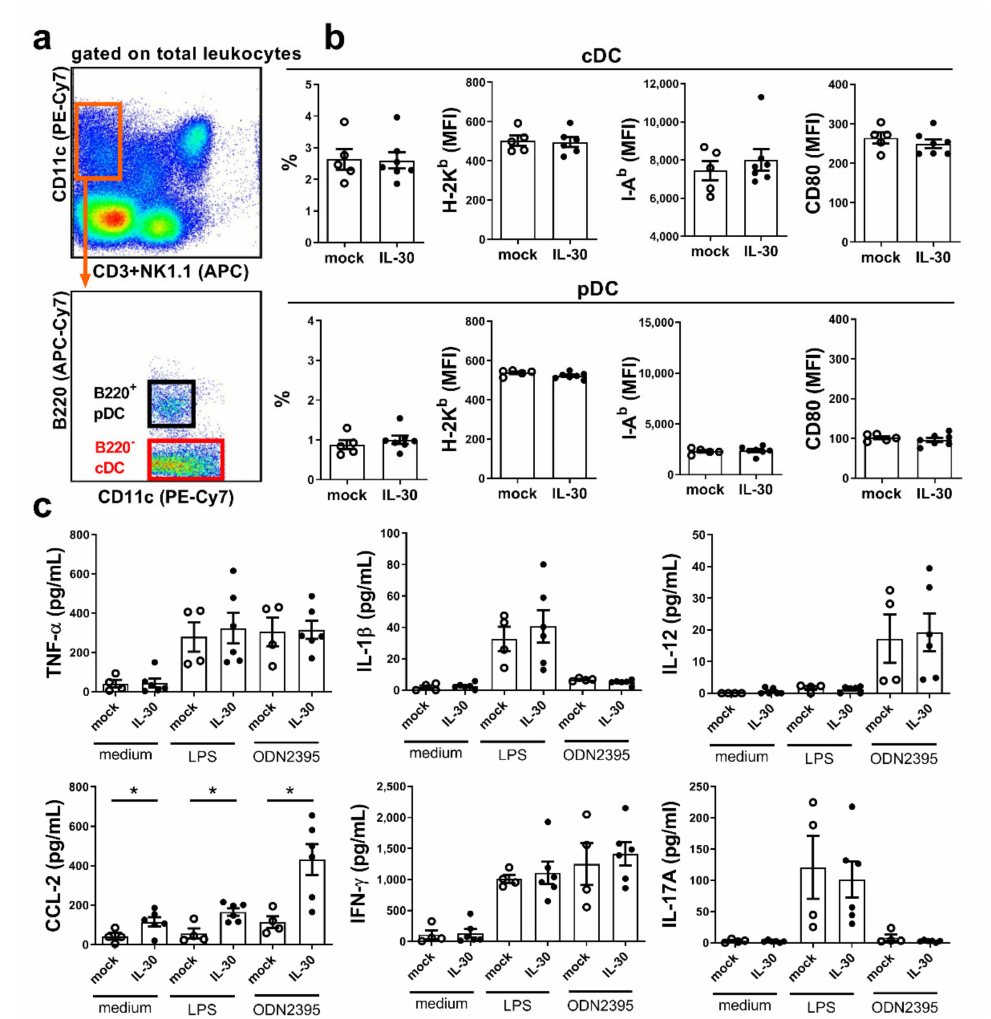
Figure 4. IL-30 did not affect antigen-presenting cells in 2-OA-OVA-induced autoimmune cholangitis mice. Mice were injected with AAV-mIL-30 or AAV-mock at 3 weeks after the first 2-OA-OVA immu- nization and sacrificed at Week 5. ( a ) Representative flow plots show gating strategies of conventional dendritic cells (cDCs) and plasmacytoid dendritic cells (pDCs). ( b ) The percentage and H-2K b , I-A b , and CD80 expression of cDCs and pDCs were detected using flow cytometry. cDCs were identified as CD3 − NK1.1 − CD11c + B220 − cells, whereas pDCs were identified as CD3 − NK1.1 − CD11c + B220 + cells. ( c ) Liver leukocytes were isolated, stimulated with LPS or ODN2395, and their cytokine/chemokine production was detected by performing a fluorescent bead-based multiplex immunoassay. Each dot represents an individual mouse. n = 4–6 mice per group. All error bars denote ± SEM. *, p <